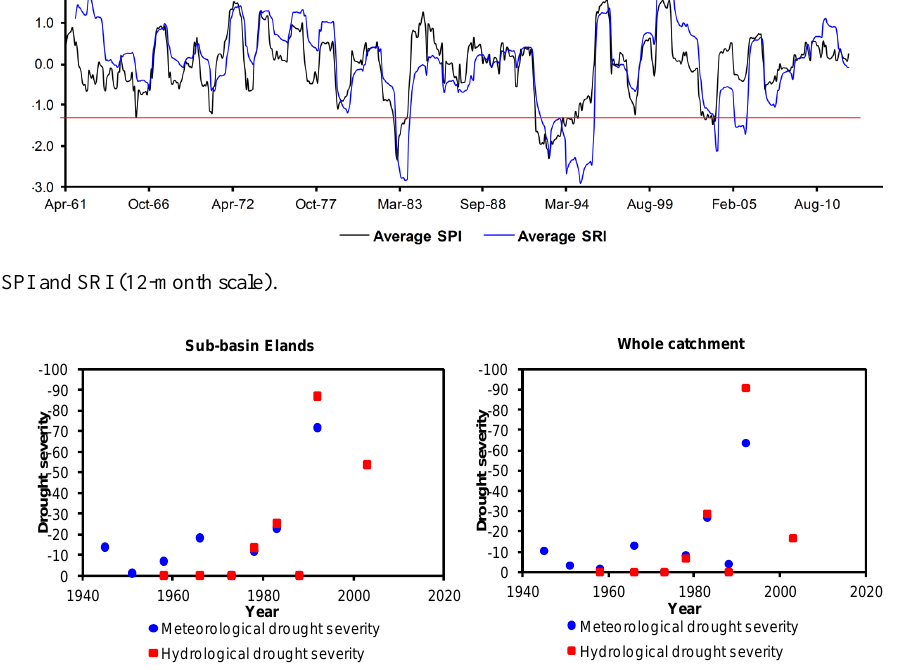
Figure 4. Drought severity in sub-catchment Elands and the whole catchment.